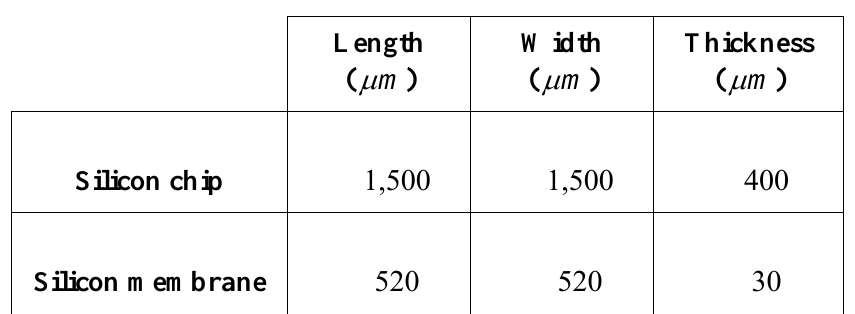
Table 1. Sensor parameters.